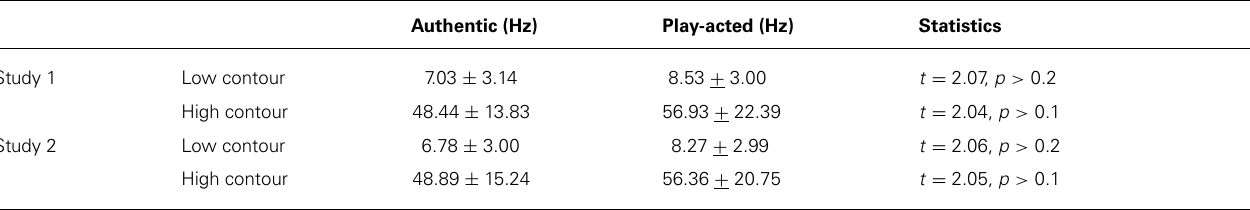
Table 1 | Mean values of high and low stimulus groups by contour (standard deviation of